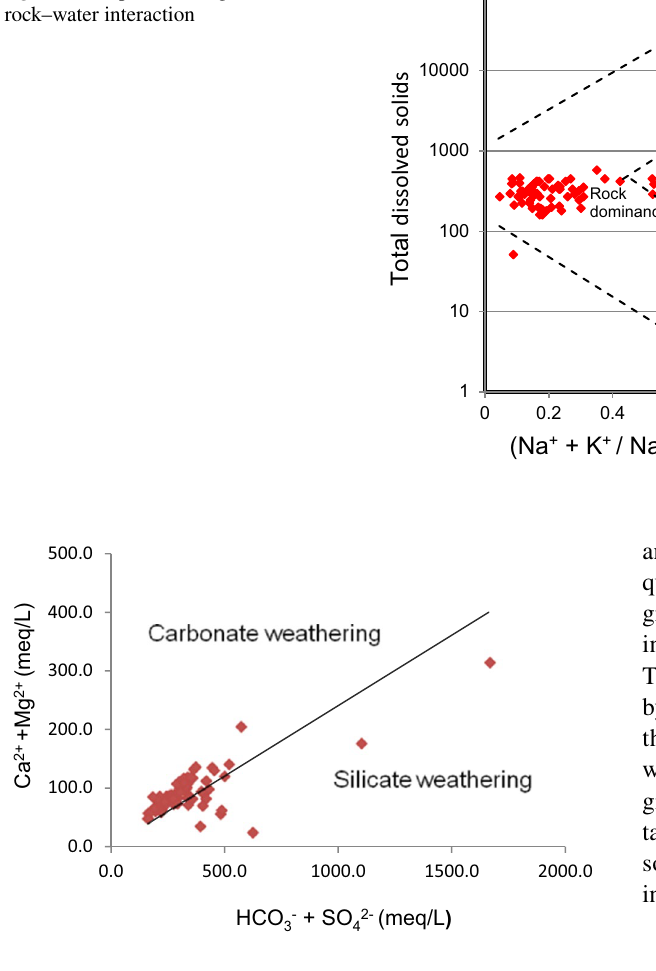
Fig. 4 Gibbs plot showing the rock–water interaction